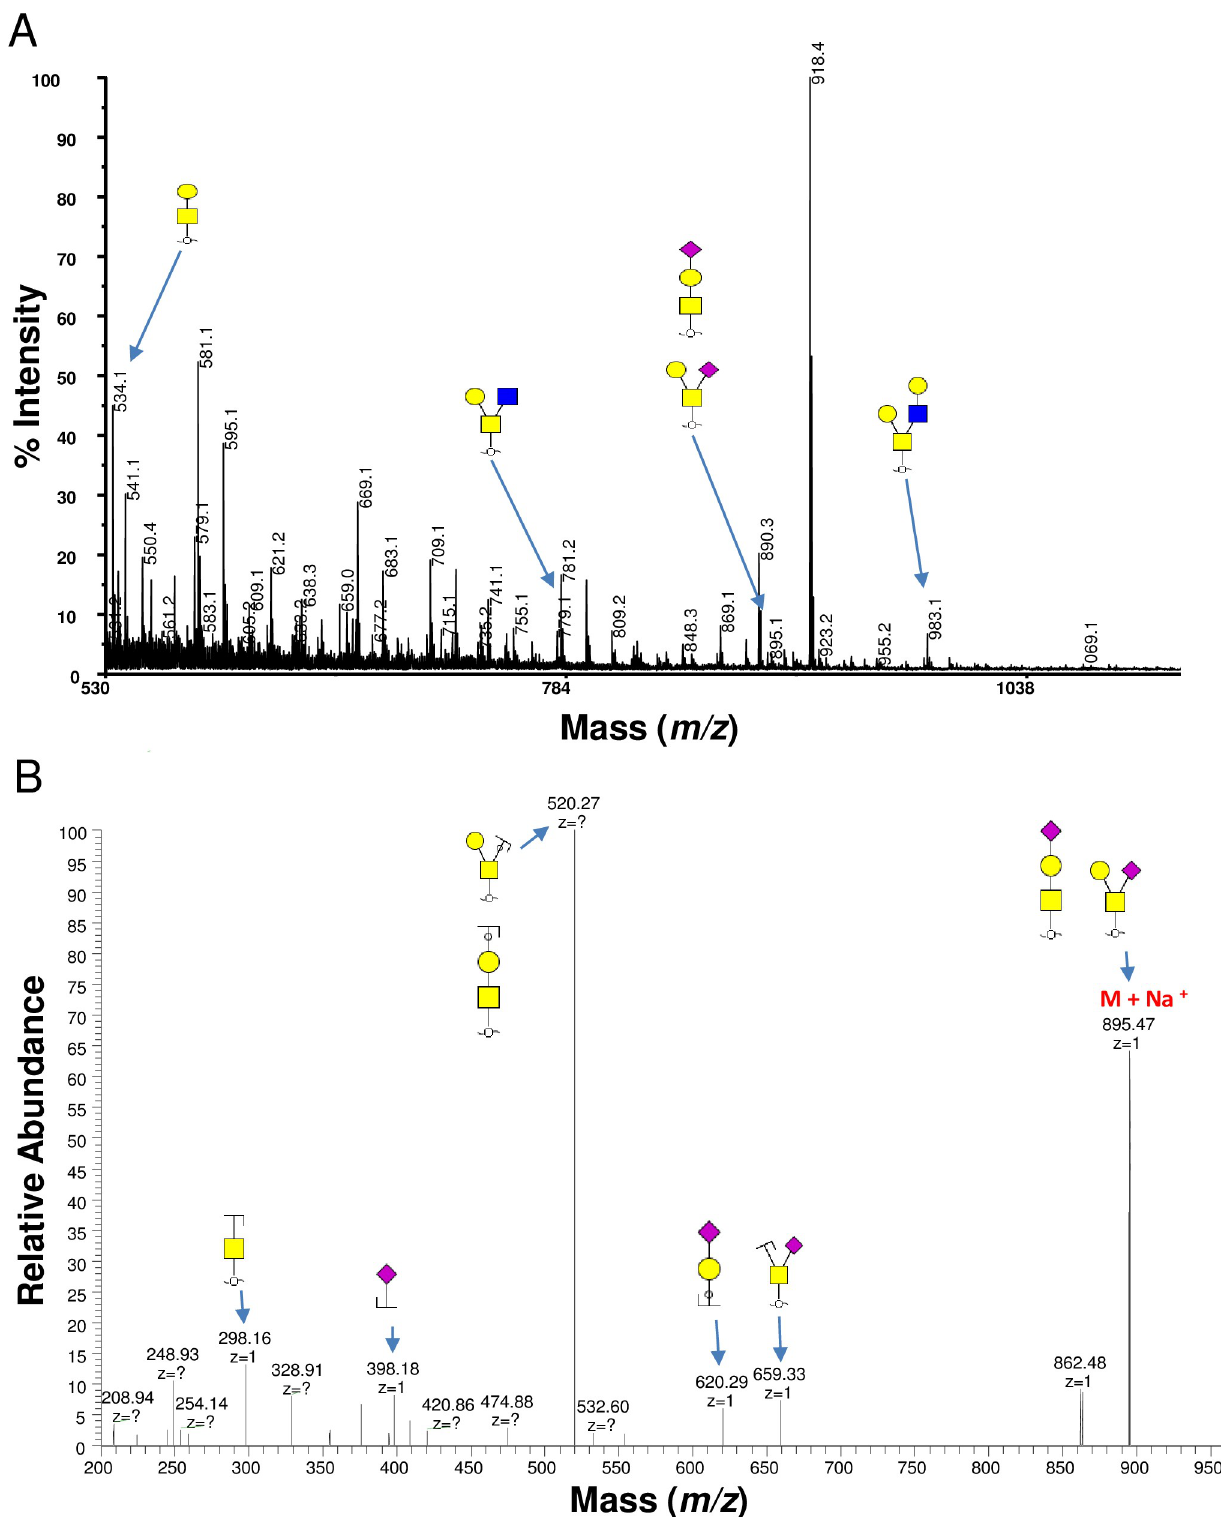
Fig 6. The representative MALDI-TOF-MS and ESI-MS/MS spectrum of O -glycans. MALDI-TOF-MS spectrum of permethylated O -glycans released by β -elimination (A) and representative HCD MS2 fragmentation spectra at m/z 895 [M + Na]1+ (B).